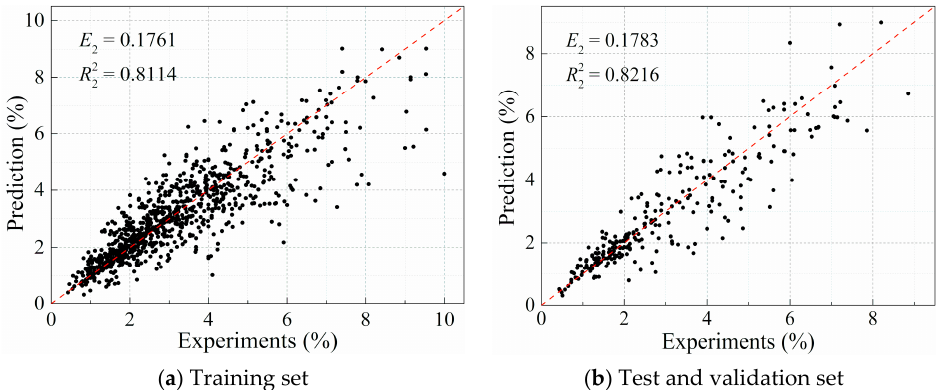
Figure 8. Comparison of experimental results of the ultimate drift and predicted results from the ANN model.